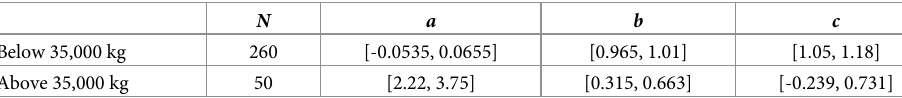
Table 1. Confidence intervals (at the 0.95 level) for intercepts and coefficients using Eq